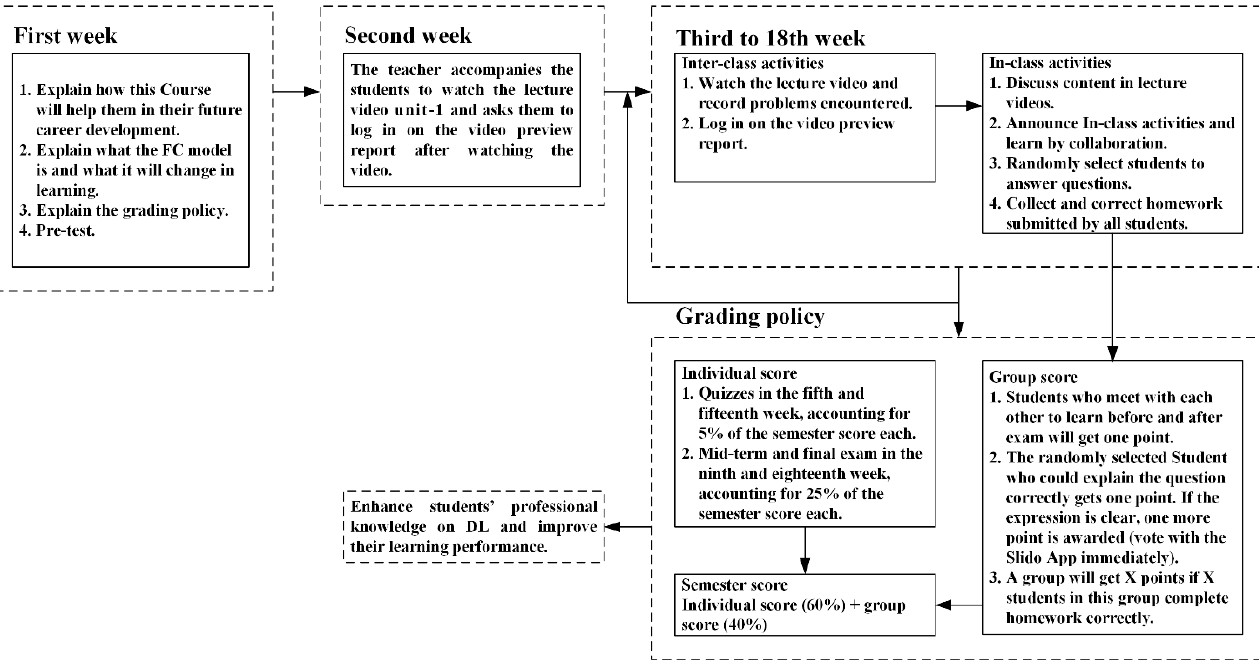
Figure 5. Lecture Video Demonstration—Snapshot of Digital System Conversion Video.